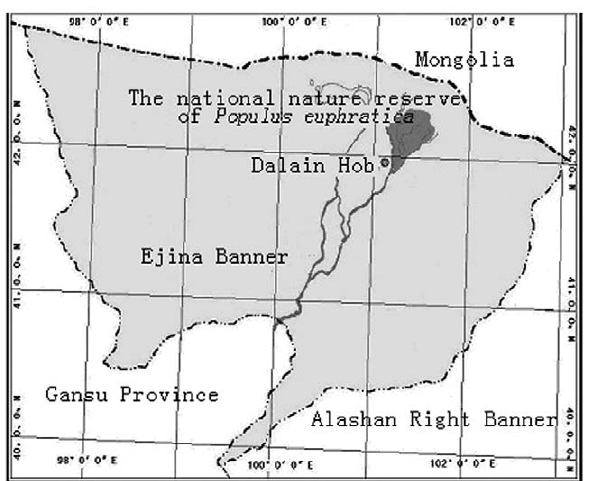
Figure 5. Location of study area. All field investigations were conducted in the National Natural Reserve of Populus euphratica in Ejina